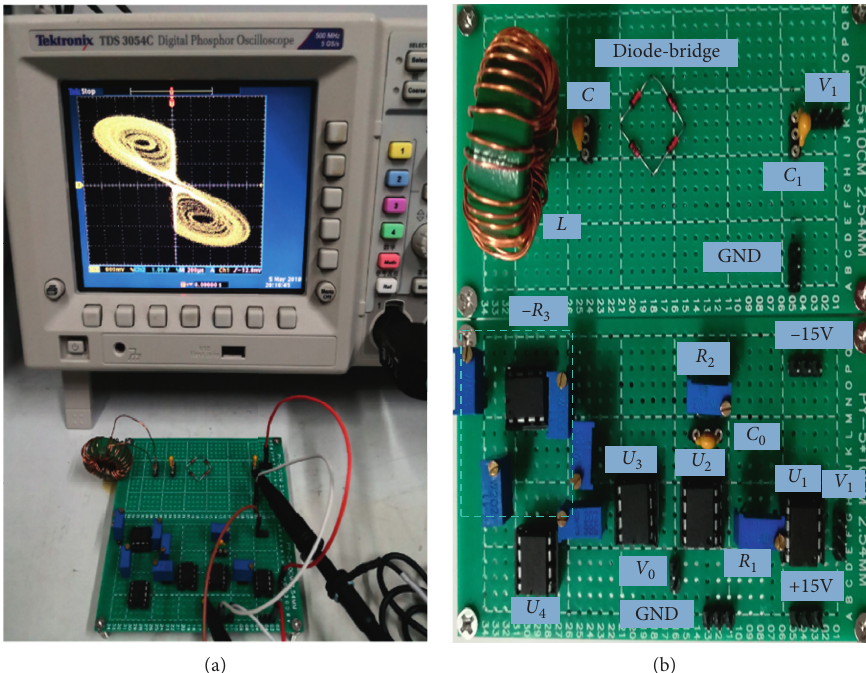
Figure 9: The hardware experimental circuit of the three-element-based circuit. (a) An overviewed graph. (b) An enlargement of on-breadboard circuit.